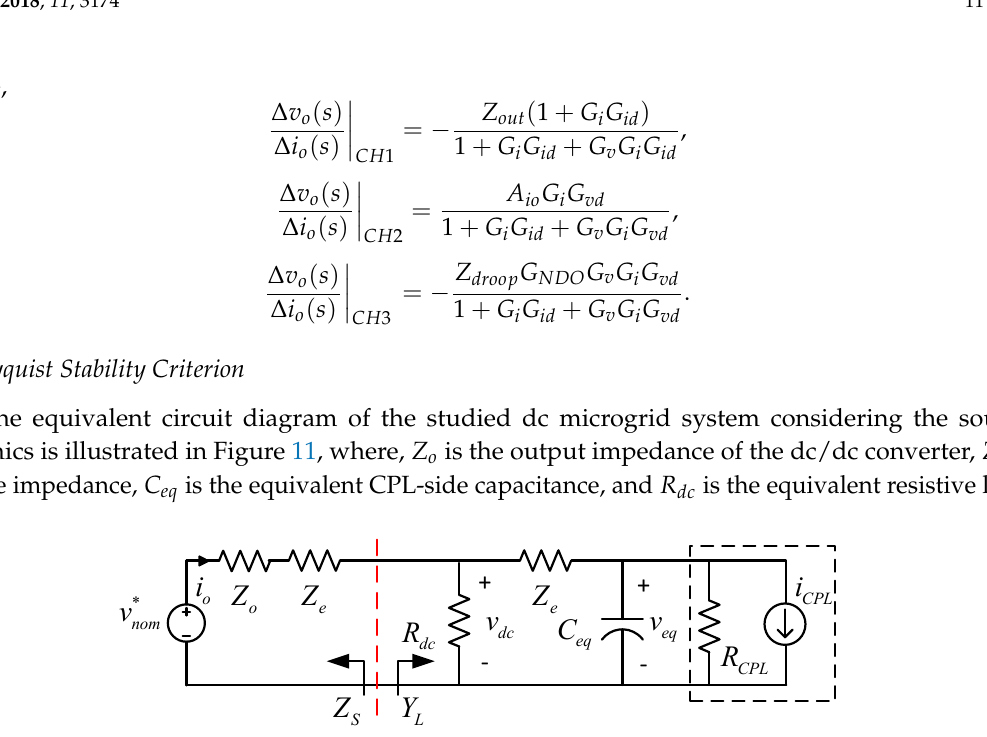
Figure 11. Equivalent circuit diagram of the studied dc microgrid system.